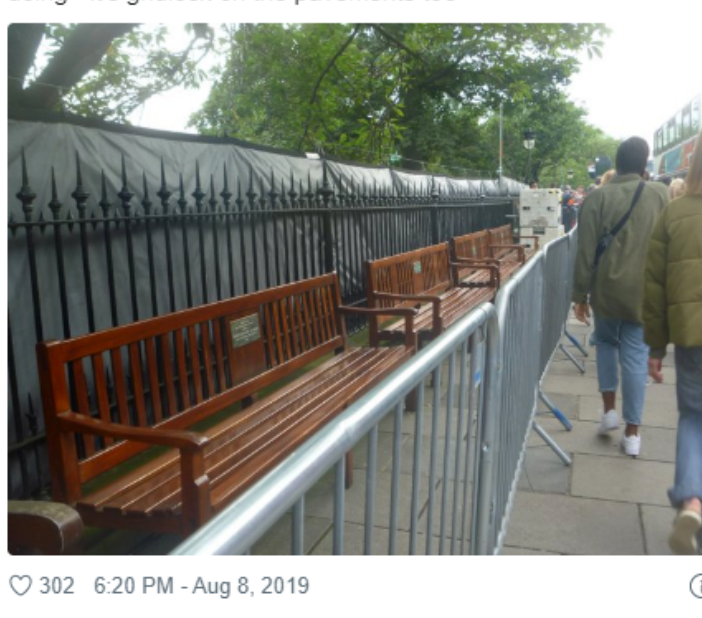
Figure 2. Barriers and curtains overlooking West Princes Street Gardens. Source: Wilson (2019). Princes Street Gardens, opening mid-November